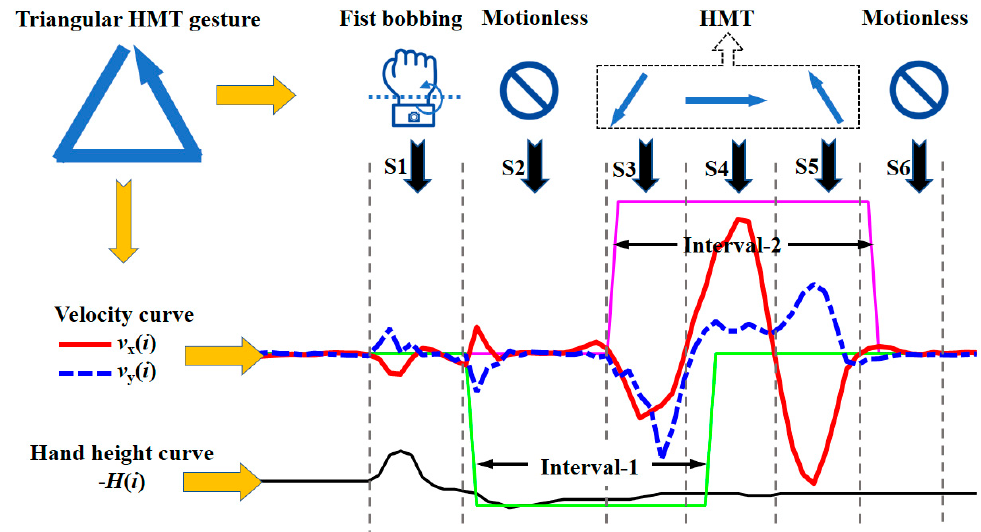
Table 2. Segmentation accuracy with different time-window widths of interval-1.